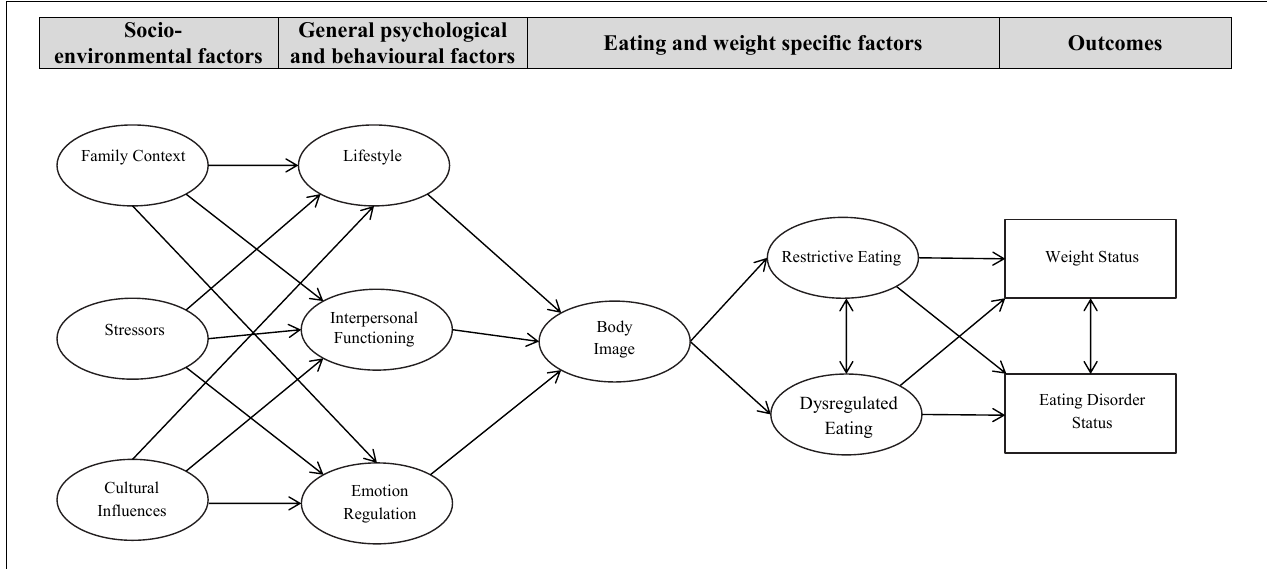
FIGURE 1 | Hypothesized model representing shared pathways to weight and eating disorder status. Family Context: family cohesion, family adaptability, family eating patterns, parents concern with thinness, weight-based teasing from parents; Stressors: negative life events, weight-based teasing from peers, perceived stress; Cultural Influences: internalization of beauty ideals, awareness of beauty ideals, peer concern with thinness; Lifestyle; exercise, sedentary behaviors; Interpersonal Functioning: attachment, non-assertiveness, connection(s) with a supportive person; Emotion Regulation: low mood, anxiety, emotion-oriented coping, inward expression of anger, outward expression of anger; Body Image: appearance esteem, weight esteem, beliefs about appearances; Restrictive Eating: restrained eating; and Dysregulated Eating: emotional eating and external